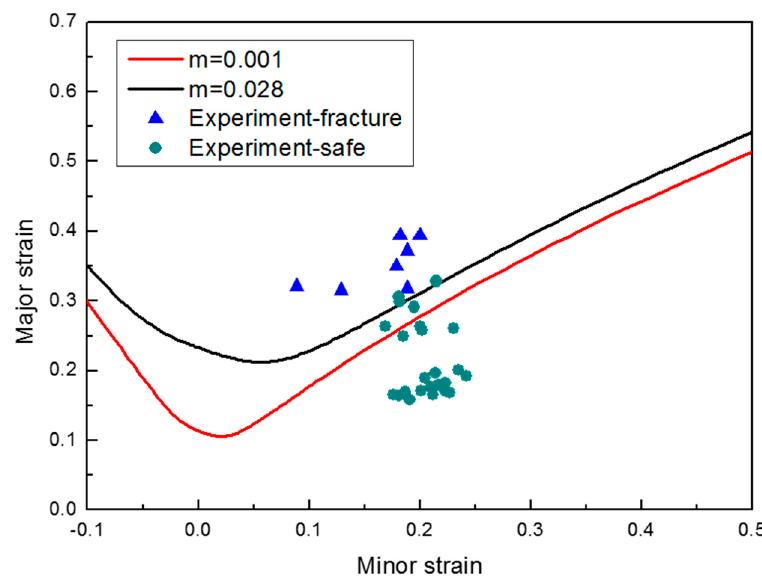
Figure 16. Evaluation of the theoretical forming limit diagram using experimental results.